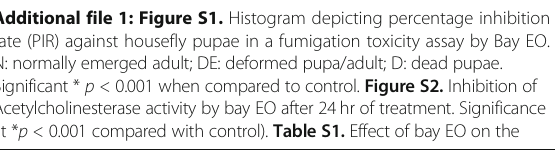
Additional file 1: Figure S1. Histogram depicting percentage inhibition rate (PIR) against housefly pupae in a fumigation toxicity assay by Bay EO. N: normally emerged adult; DE: deformed pupa/adult; D: dead pupae. Significant * p < 0.001 when compared to control. Figure S2. Inhibition of Acetylcholinesterase activity by bay EO after 24hr of treatment. Significance at * p < 0.001 compared with control). Table S1. Effect of bay EO on